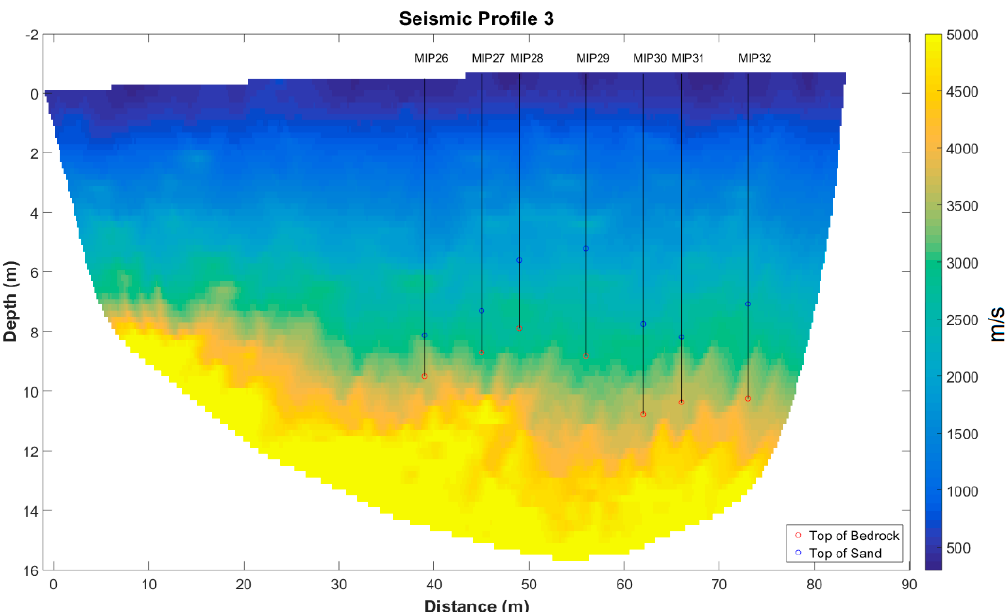
Figure 4. Inverted result from seismic refraction tomography from SeismicLine3. The interpreted MIP sounding [27,28] are plotted on top of the tomogram to be used for calibrating the seismic result.